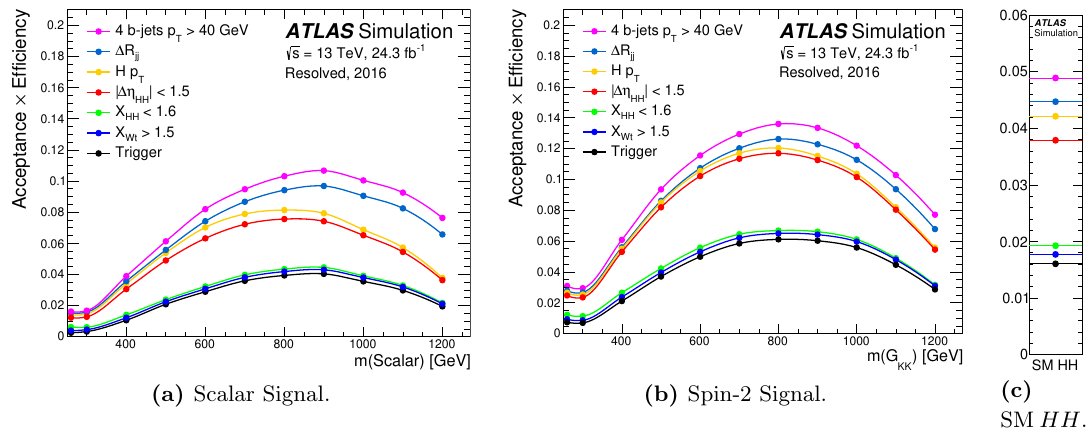
Figure 2. The selection acceptance times e(cid:14)ciency at each stage of the event selection for (a) a narrow-width scalar and (b) G KK ! HH ! b (cid:22) bb (cid:22) b with k=M Pl = 1 for a range of resonance